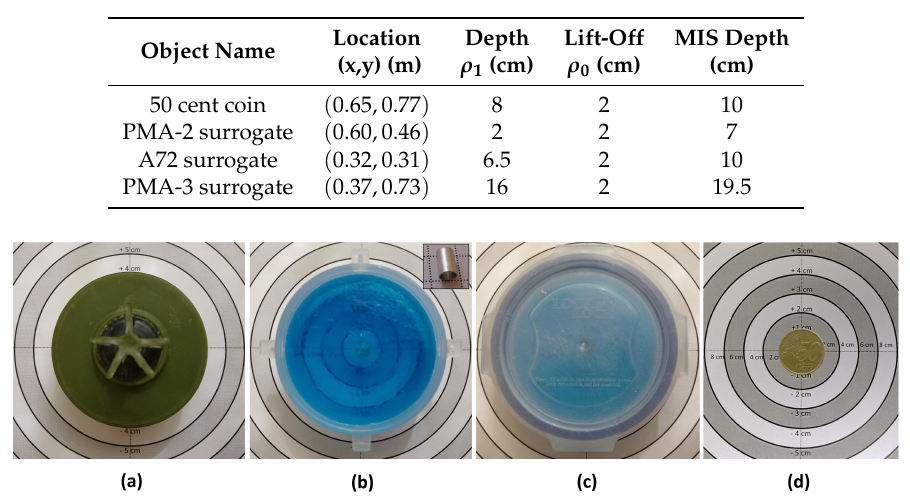
Table 3. Location of metallic component of target objects used in the experiment.